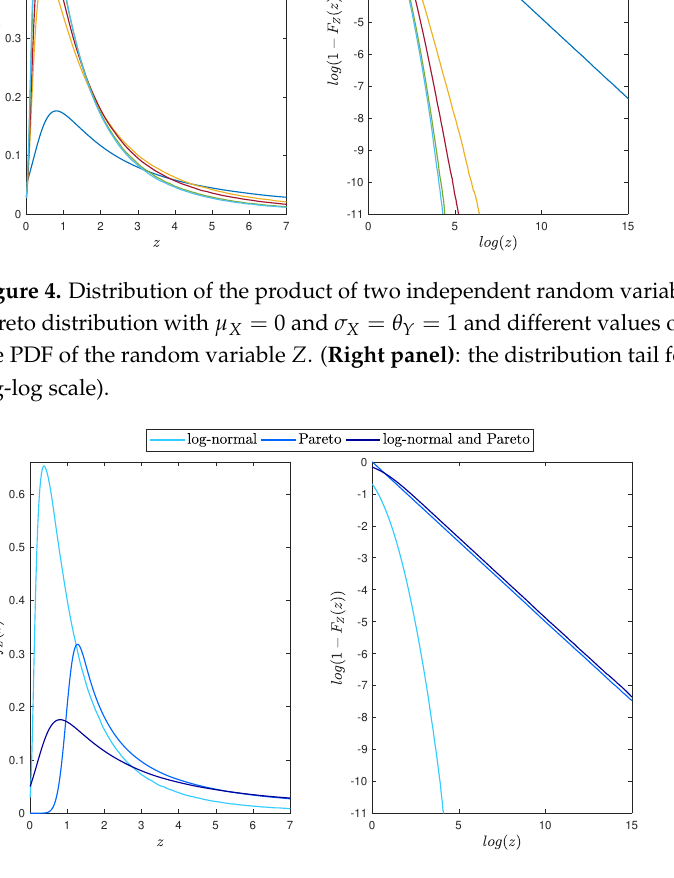
Figure 5. ( Left panel ): the PDF of the random variables X (log-normal), Y (Pareto) and Z . ( Right panel ): the distribution tails. The parameters are equal: µ X = 0 and σ X = θ Y = 1 and a Y =